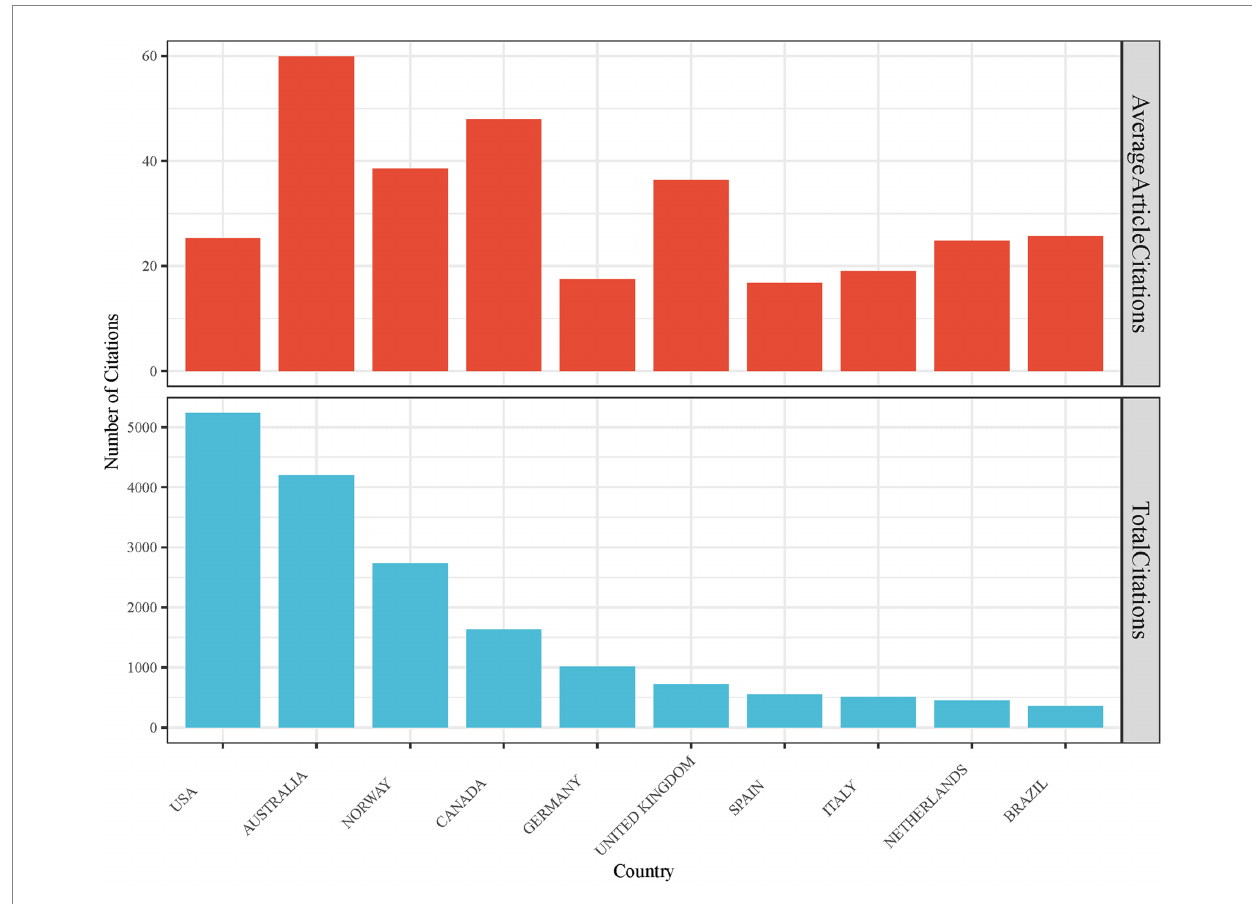
FIGURE 6 Total and average citations for the top 10 most frequently cited countries.